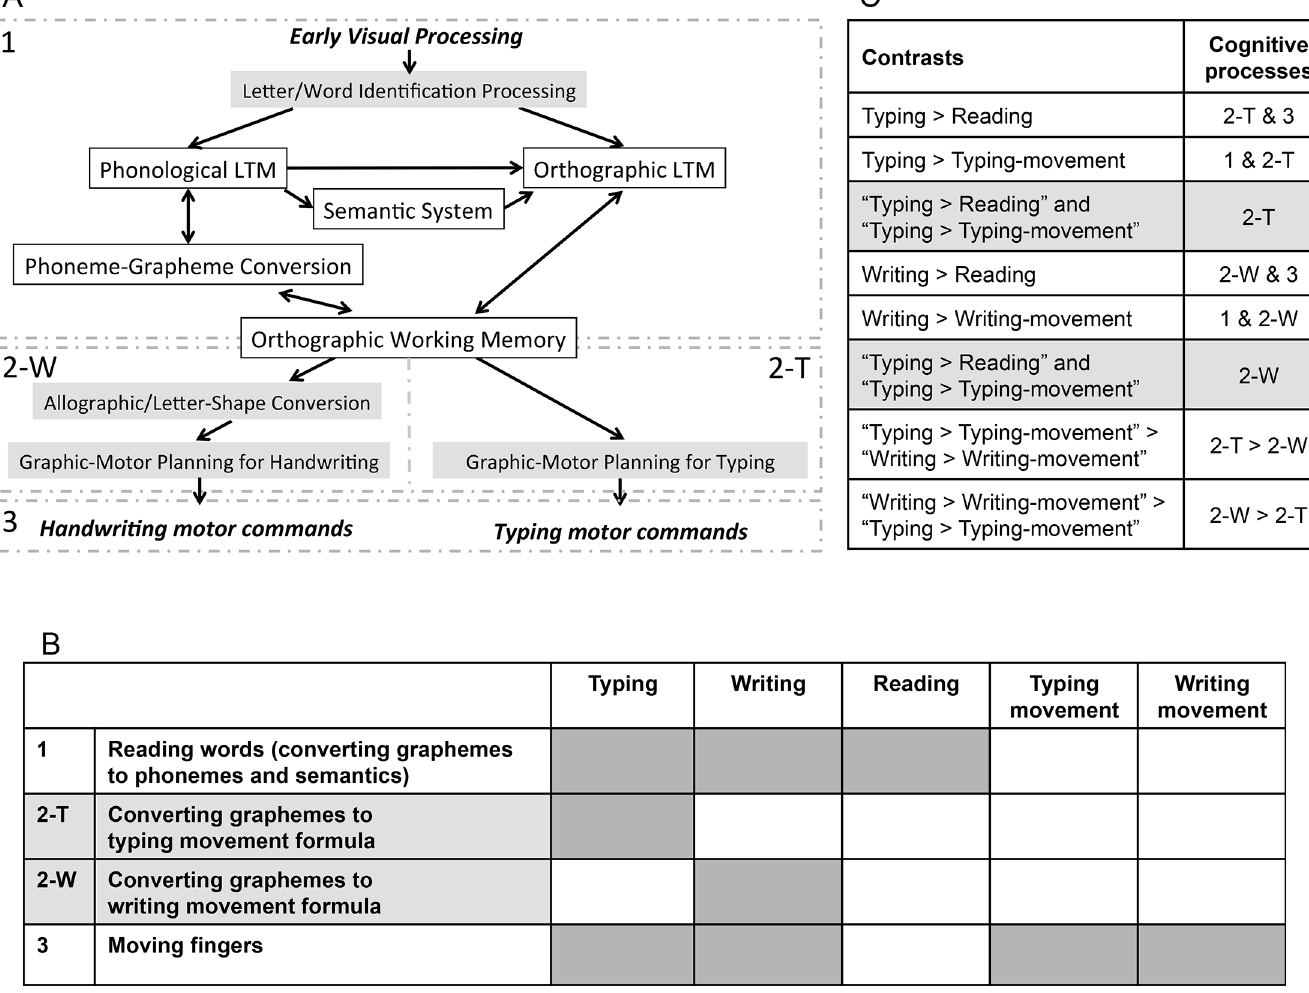
Fig 1. A diagram of the assumptions underlying the present analysis. (A) The cognitive model of handwriting and typing used in the present study. The labels 1, 2-W, 2-T, and 3 correspond to the labels in Fig 1B. (B) The simplified cognitive processes of typing and writing used in the present analysis. (C) The contrasts and corresponding cognitive processes. The labels 1, 2-W, 2-T, and 3 correspond to the labels in Fig 1B. Grey shading indicates conjunction